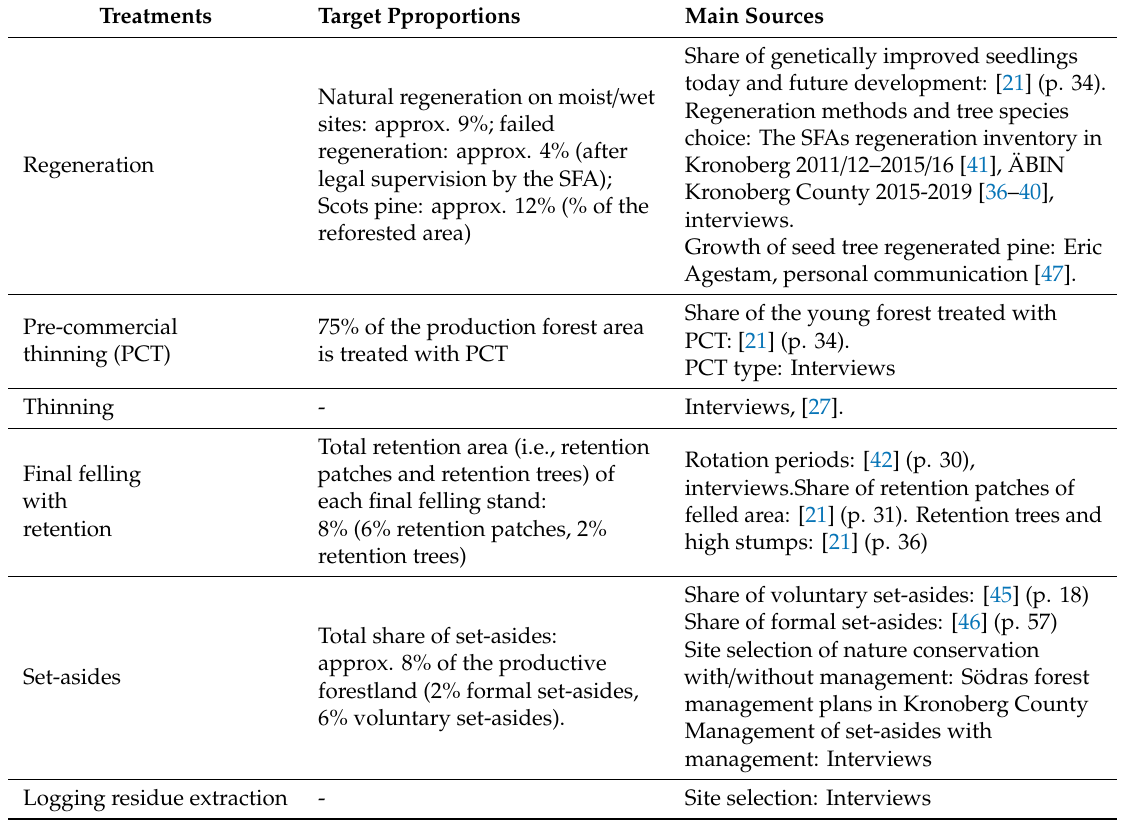
Table 1. Summary of main sources used in the mapping of current management practices. The table also provides some target proportions for di ff erent treatments that have been guiding the settings in the projections.